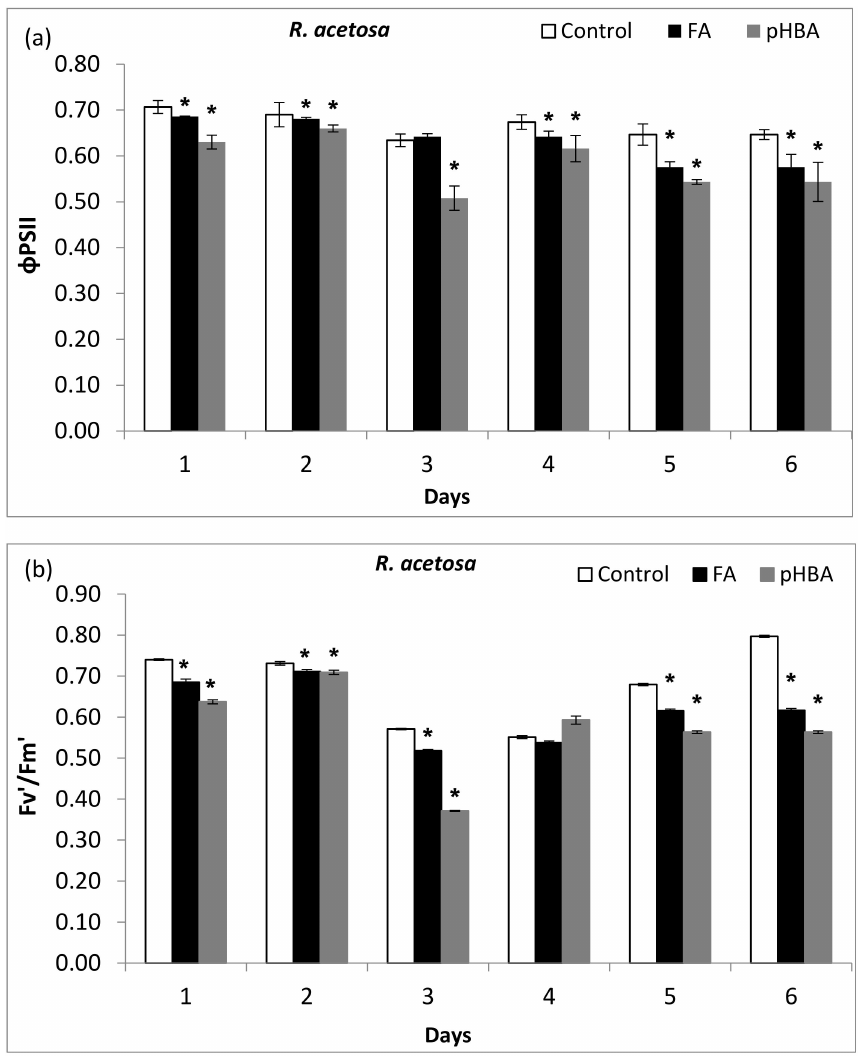
Figure 2. Changes in maximum quantum yield of photosystem II ( Φ PSII) ( a ) and efficiency of PSII reaction centers in the light-adapted (F v’ /F m’ ) ( b ) state in leaves of Rumex acetosa from days 1 to 6 following exposure to ferulic acid (FA) and p -hydroxybenzoic acid (pHBA) at 1.5 mM concentra- tion. Every column in each graph represents mean ( ± S.E.) of three replicates. * Asterisks indicate significant differences at p ≤ 0.05 with respect to